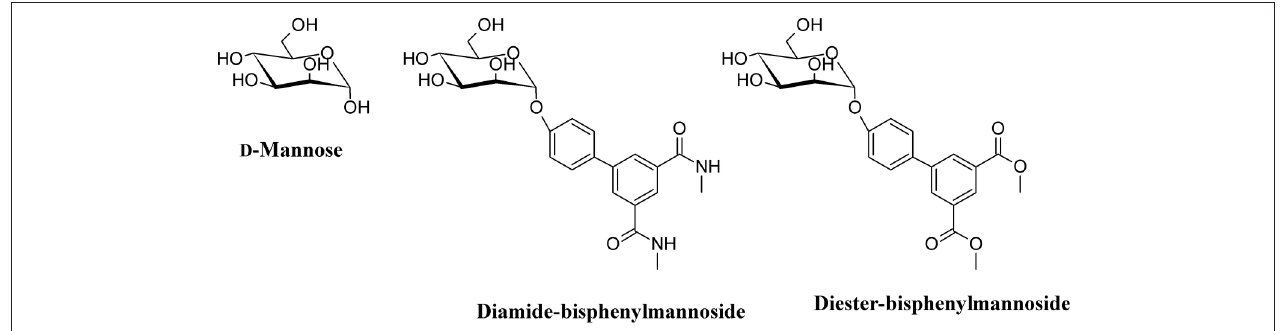
FIGURE 6 | Structure formulae of D -mannose and some bioactive mannosides.